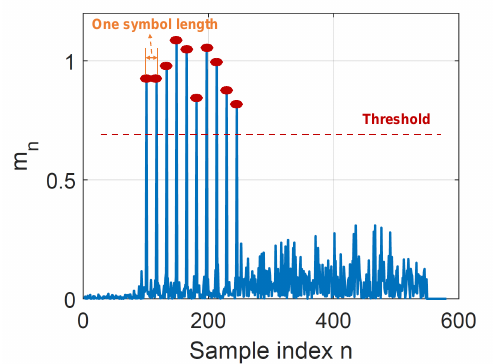
Figure 17. Complex decision rule for cross-correlation.